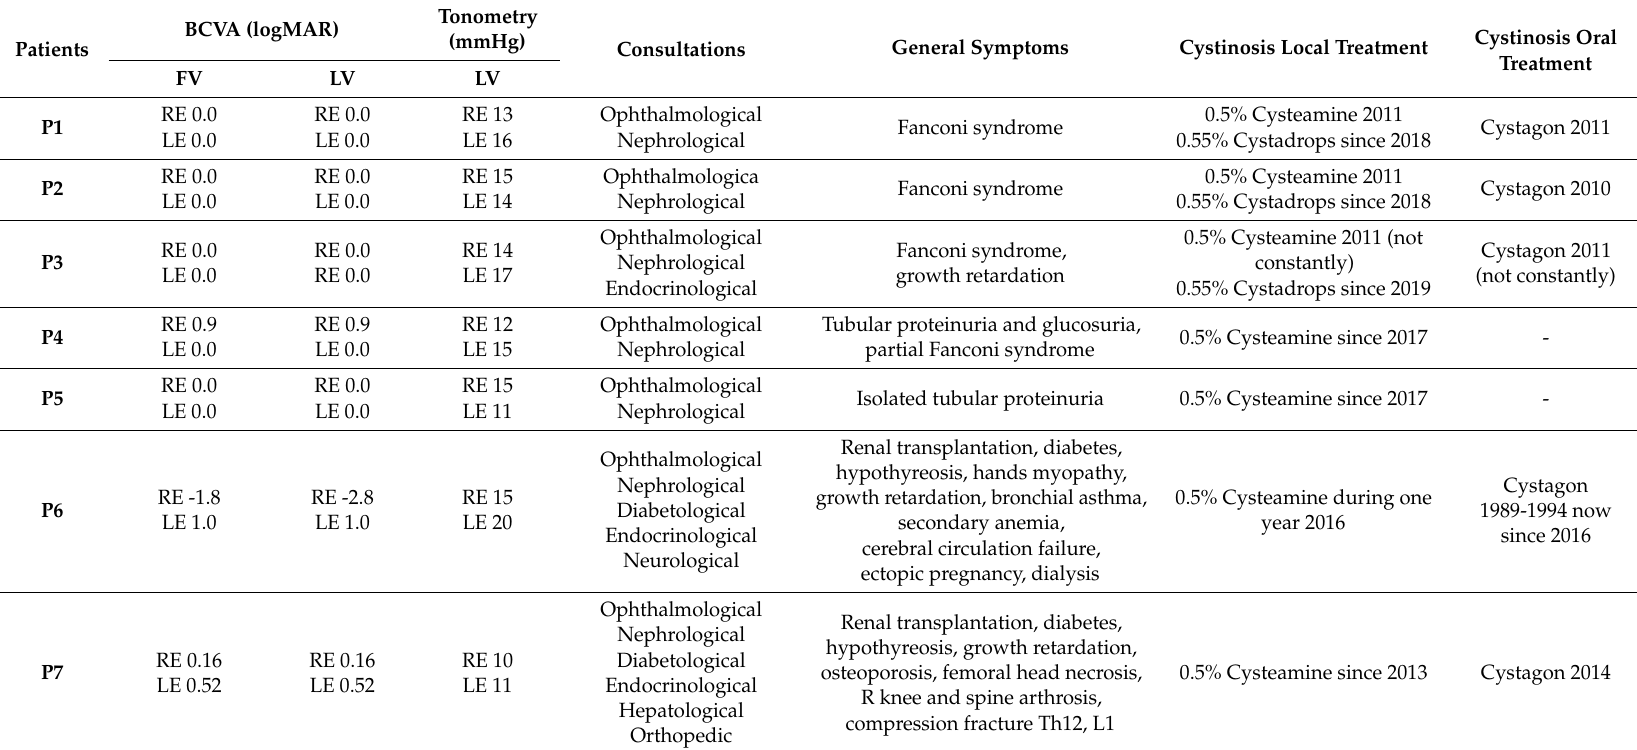
Table 2. Results of ophthalmological exams with general symptoms and